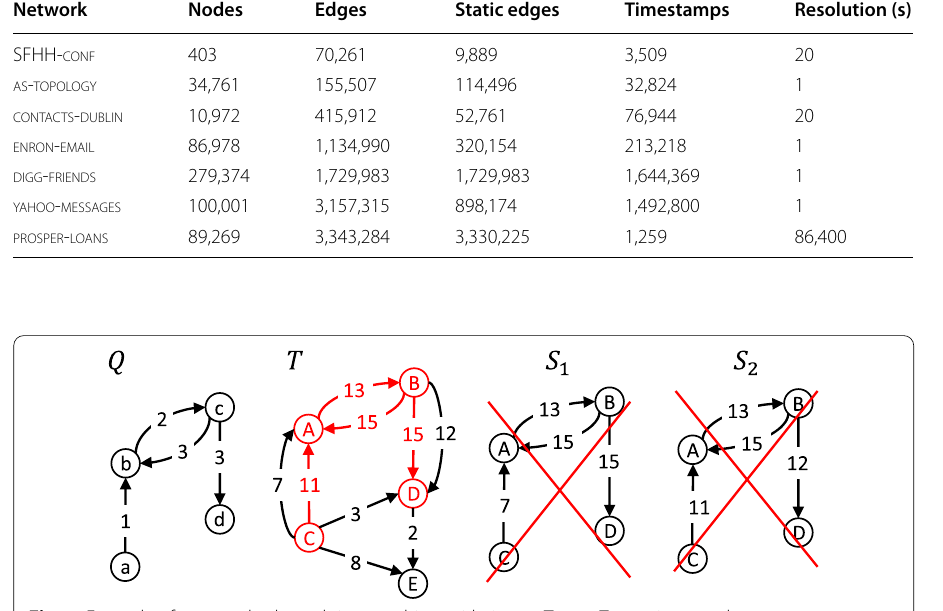
Fig. 1 Example of temporal subgraph isomorphism with (cid:31) = 5 . Target T contains exactly one occurrence of query Q , which is the subgraph formed by nodes and edges colored in red. Subgraph S 1 is not a solution